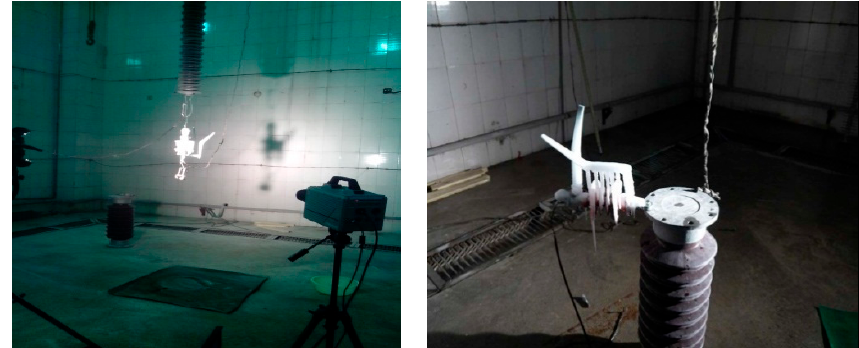
Figure 4. Icing withstand voltage test pictures in the UHV DC base of SGCC.